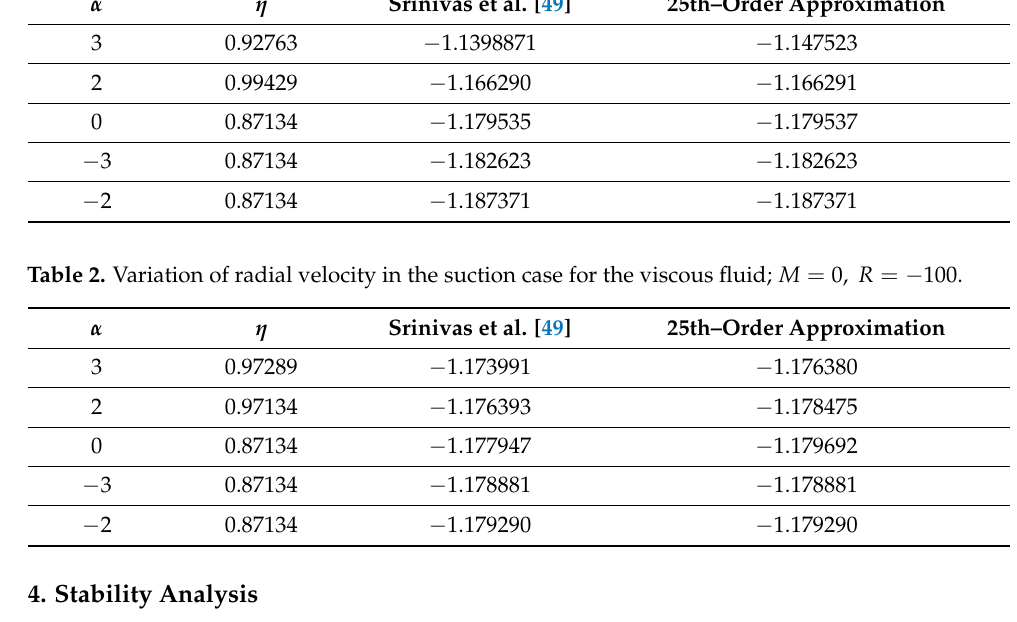
Table 1. Variation of radial velocity in the suction case for the viscous fluid; M = 0, R = − 50. α η